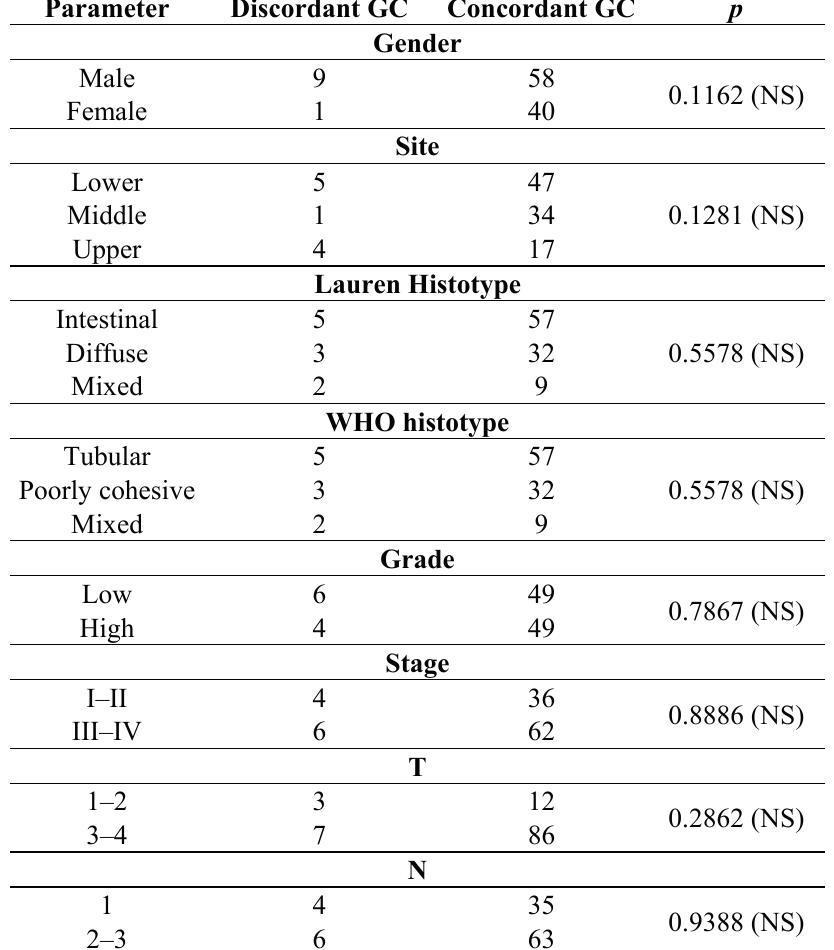
Table 2. Clinico-pathological parameters in relation to concordance of HER2